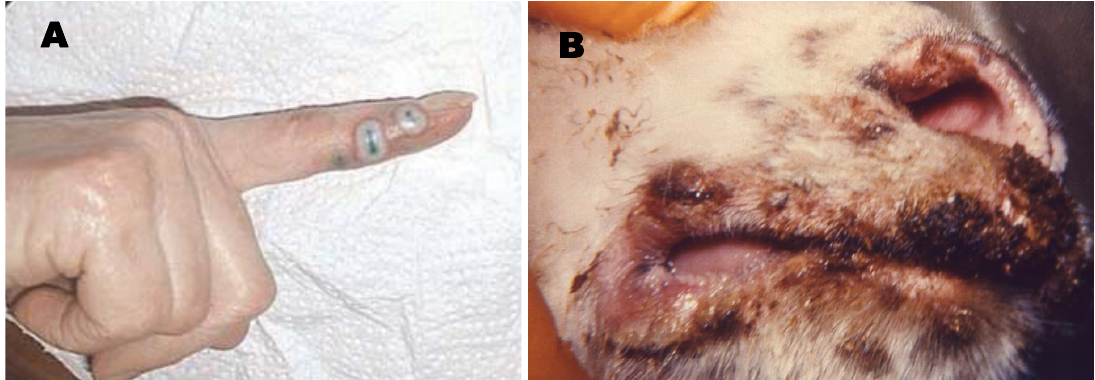
Figure 3. Clinical presentations of orf lesions in a human and a sheep. ( A ) Lesions at the site of a bite from a sheep on day 19 postinoculation [83]; ( B ) Proliferative lesions involving the lips and muzzle of a goat infected with orf. (Photo A courtesy of Scottish Medical Journal Copyright 2011 Royal Society of Medicine Press; Photo B provided by Callis, J.J.; and Mahy, B.W.J. courtesy of CDC Public Health Image